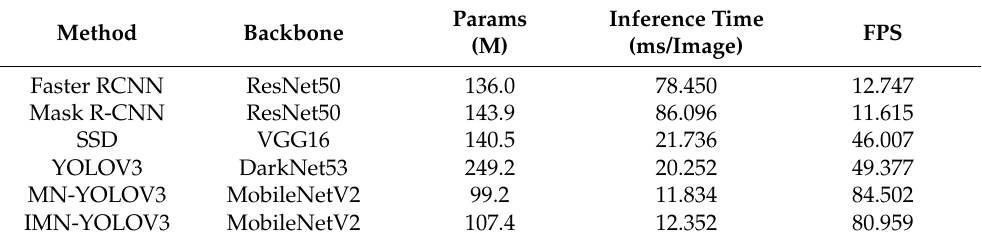
Table 6. Space complexity and detection speed of these models on